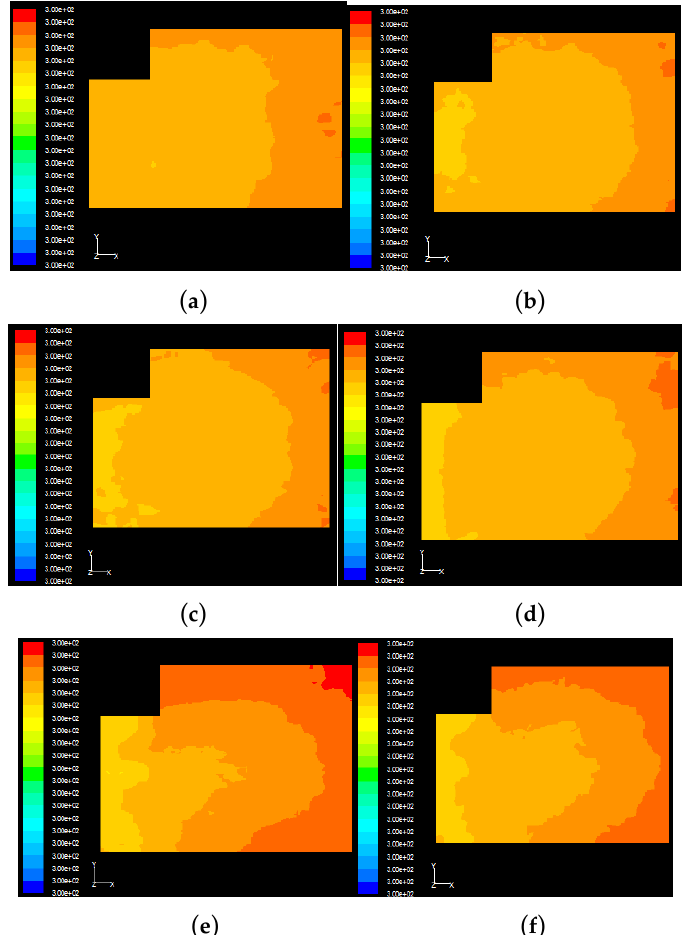
Figure 18. Indoor temperature distribution nephogram while the wind velocity v = 0.188 m/s ( a ) z = 0.10 m temperature nephogram; ( b ) z = 0.60 m temperature nephogram; ( c ) z = 0.75 m temperature nephogram; ( d ) z = 1.10 m temperature nephogram; ( e ) z = 1.70 m temperature nephogram; ( f ) z = 1.90 m temperature nephogram.